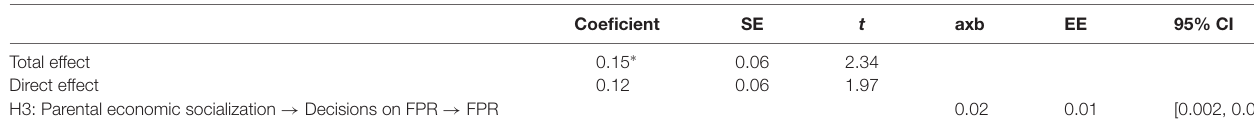
TABLE 4 | Regression results for testing mediation of decisions on FPR in the relationships between parental economic socialization and FPR. Coeficient SE